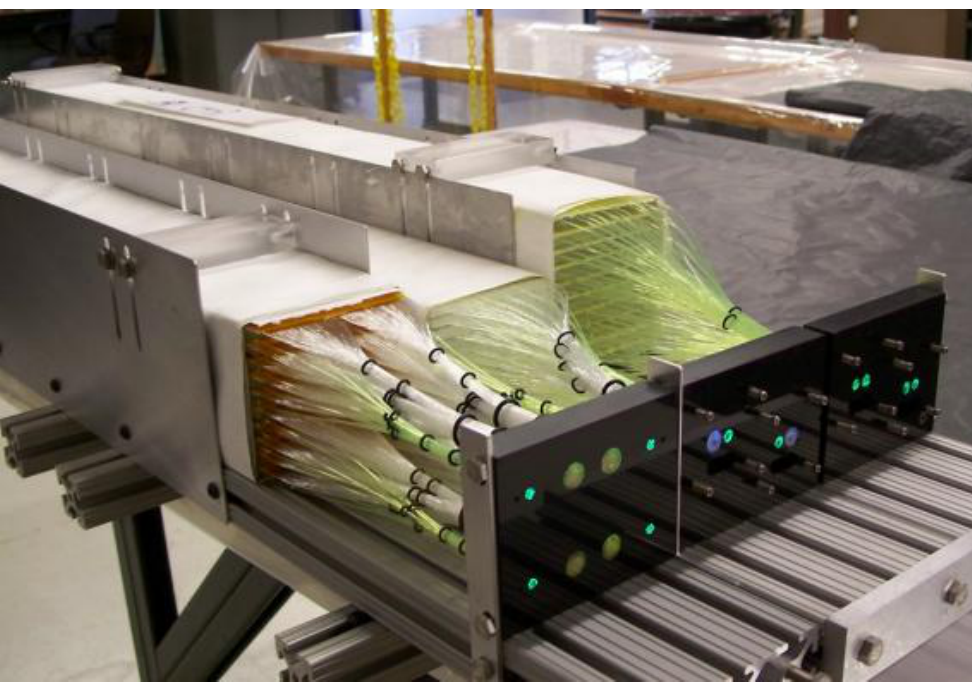
Figure 1. Three 105 cm long ADRIANO prototypes during the assembly phase at Fermilab’s Thin Film